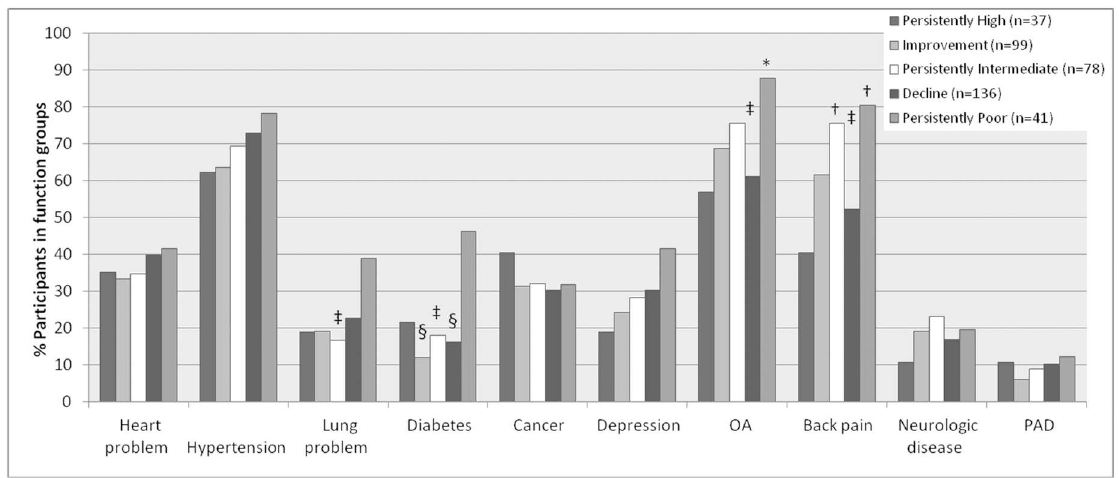
Fig 2. Baseline prevalenceof self-reported chronic diseasesby BLE mobility trajectory(N = 391). * p < 0.01,†p < 0.001for comparisons with Persistently High. ‡p < 0.01, §p < 0.001for comparisons with Persistently Poor. BLE = Basic Lower-Extremity Function; OA = Osteoarthritis; PAD = PeripheralArtery